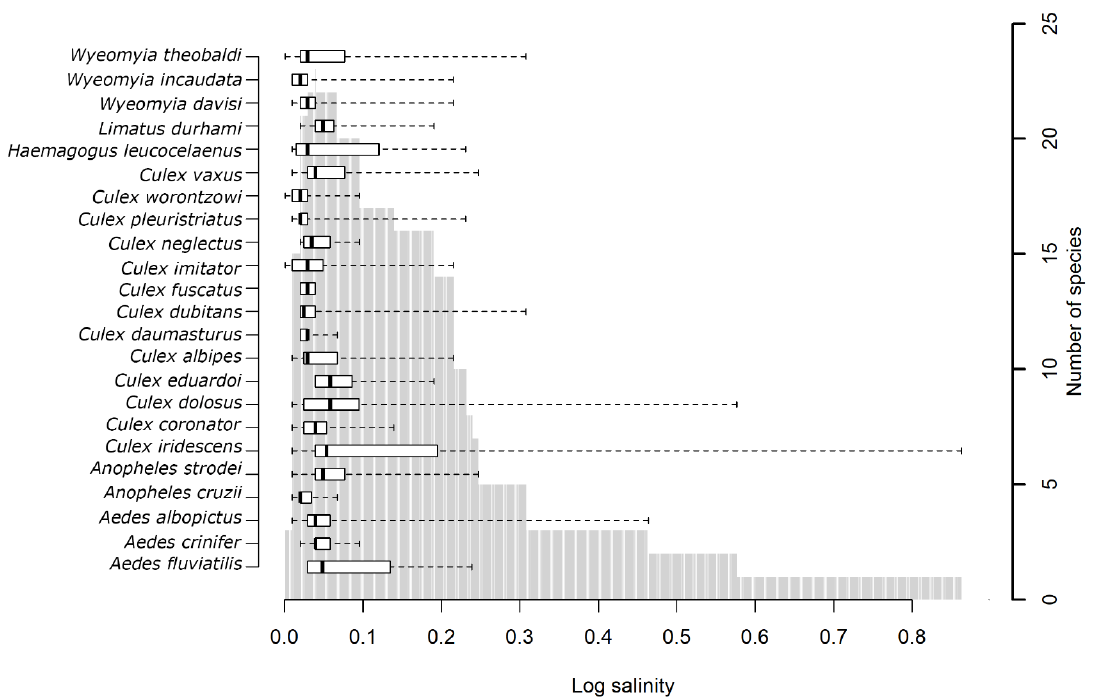
Figure 3. Variation in number of species and specimens with salinity (PSU on a log scale) of water from breeding sites. The boxplot (based on medians) and whiskers represent the range of values within which each species was found. The box represents the salinity interval within which the species was observed most frequently. The vertical gray bars represent the number of species observed for the corresponding range of salinities.